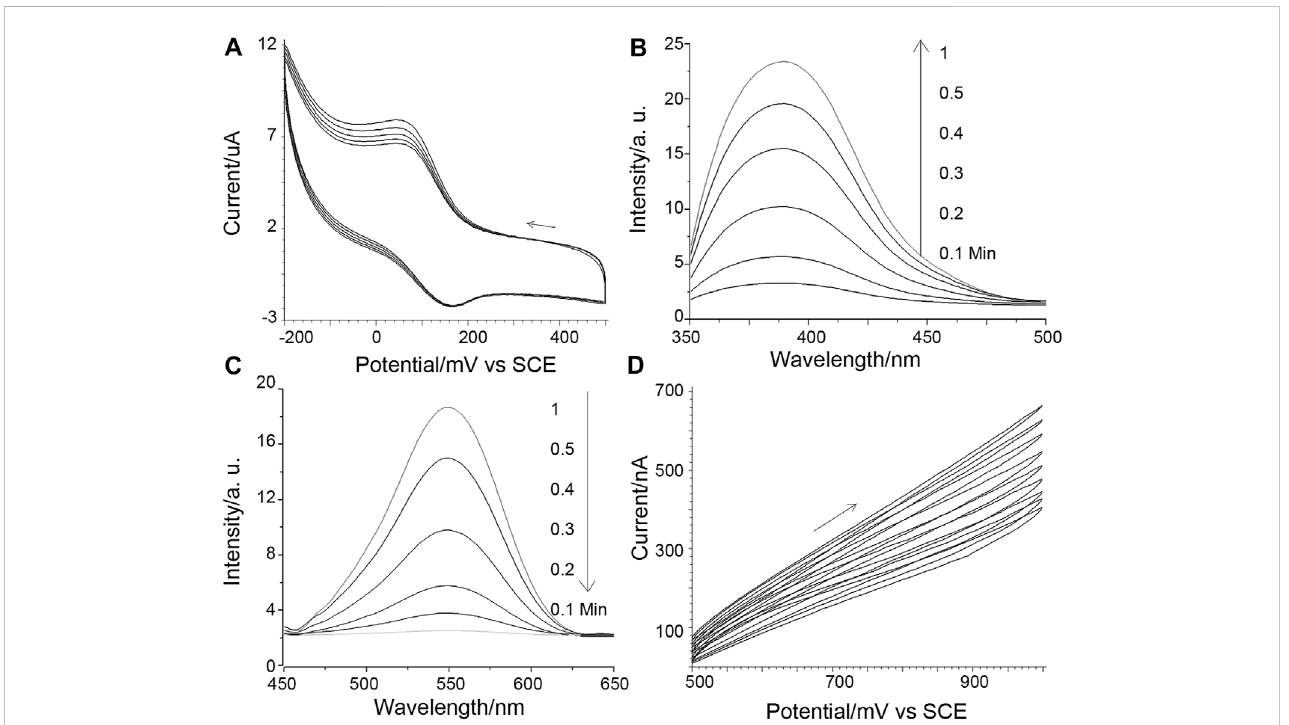
FIGURE 1 (A) Cuion cyclic voltammograms obtained for 10 nM integrin detection. The potential scanning direction is shown by an arrow, and the scan speed is 1 mV/s. (B) Di-tyrosine fl uorescence measured concurrently with (A) : The sensing interface-bearing ITO slide served as the working electrode. A salt bridge setup was employed to connect the reference and counter electrodes to the fl uorescence cuvette, which served as the electrolysis cell. (C) Tyrosine fl uorescence reactions that are parallel. (D) Paralleled peroxide evolution, 1 mv/s scan